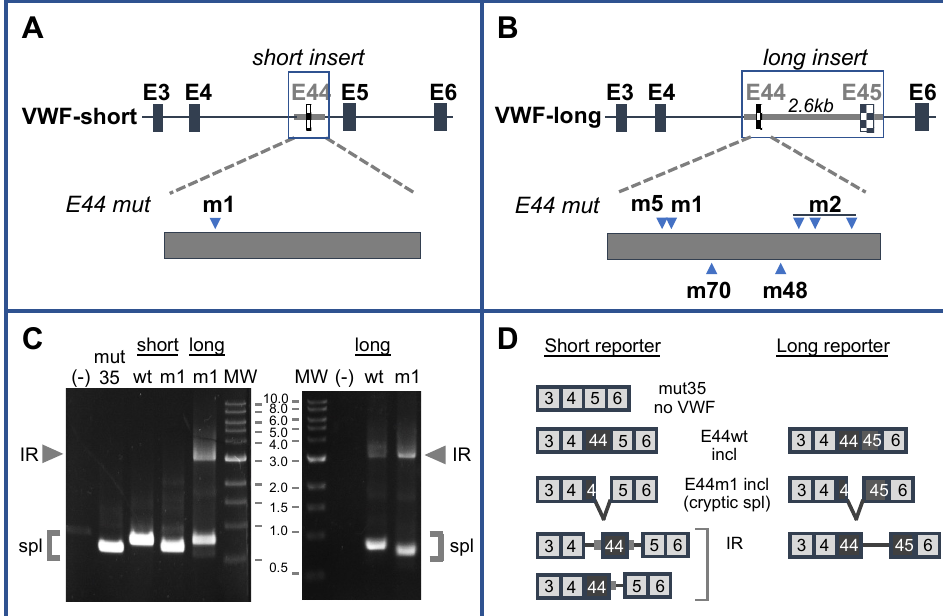
Figure 1. Engineering patient-specific retention of VWF intron 44 in minigene splicing reporters. ( A ) Structure of a short reporter. Boxed region represents VWF genomic sequence. The position of the patient’s mutation (m1) is indicated. ( B ) Structure of a long reporter. Boxed region represents VWF genomic sequence. The positions of various engineered mutations are indicated. ( C ) Gel analysis of spliced products in K562 cells generated from a parent construct lacking VWF sequences (mut35); short reporters containing normal (wt) or patient (m1) sequences for VWF E44 plus short flanking intronic sequences as shown in ( A ); long constructs containing normal (wt) or patient sequences (m1) as diagrammed in ( B ). MW standards (in kb) are shown. ( D ) Expected spliced products from short (left) and long (right) reporters. Numbered boxes indicate the exons spliced together in each transcript. IR was detected in transcripts derived from long reporters with the m1 mutation; potential IR products generated from the short reporter were not observed.